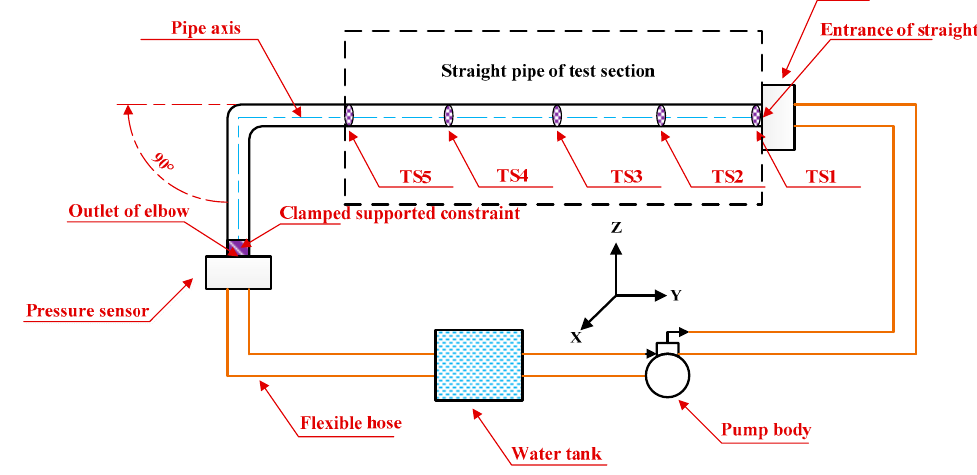
Figure 7. Schematic diagram of experiment.